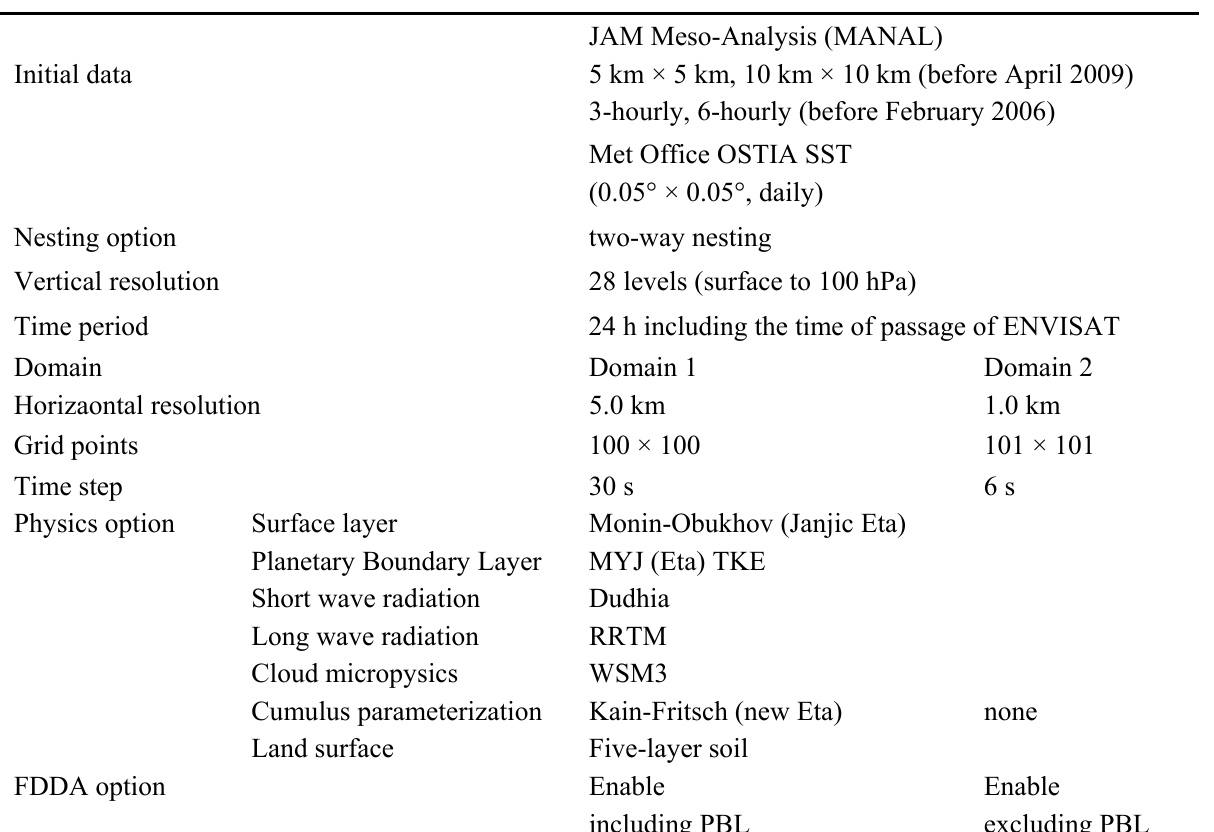
Table 2. Configurations of the mesoscale meteorological model WRF and input